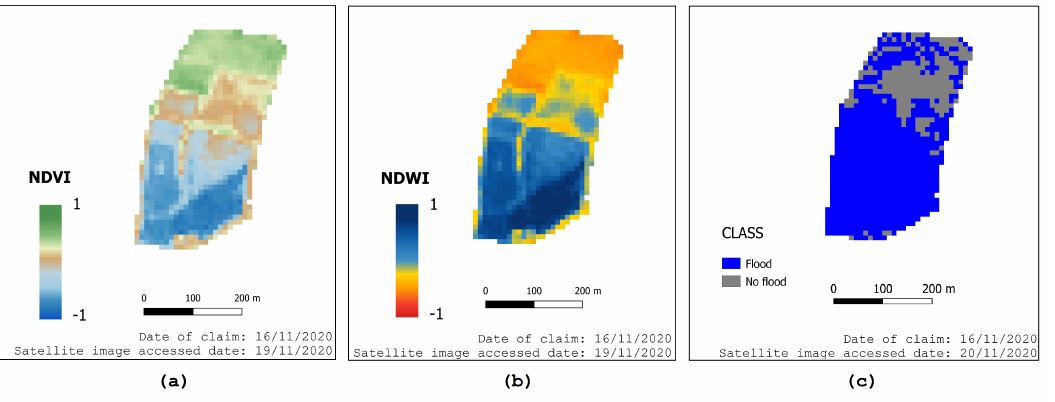
Figure 10. Predicted flood distribution in a sample flooded land plot using ( a ) the NDVI method on Sentinel-2A, ( b ) the NDWI method on Sentinel-2A and ( c ) the CART method on Sentinel-1 SAR GRD.